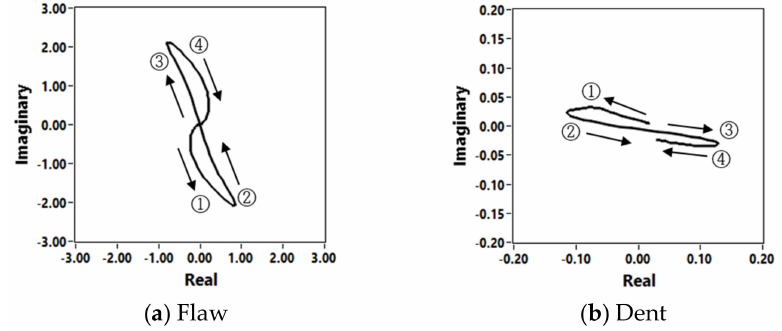
Figure 8. Comparison of lobe path direction.